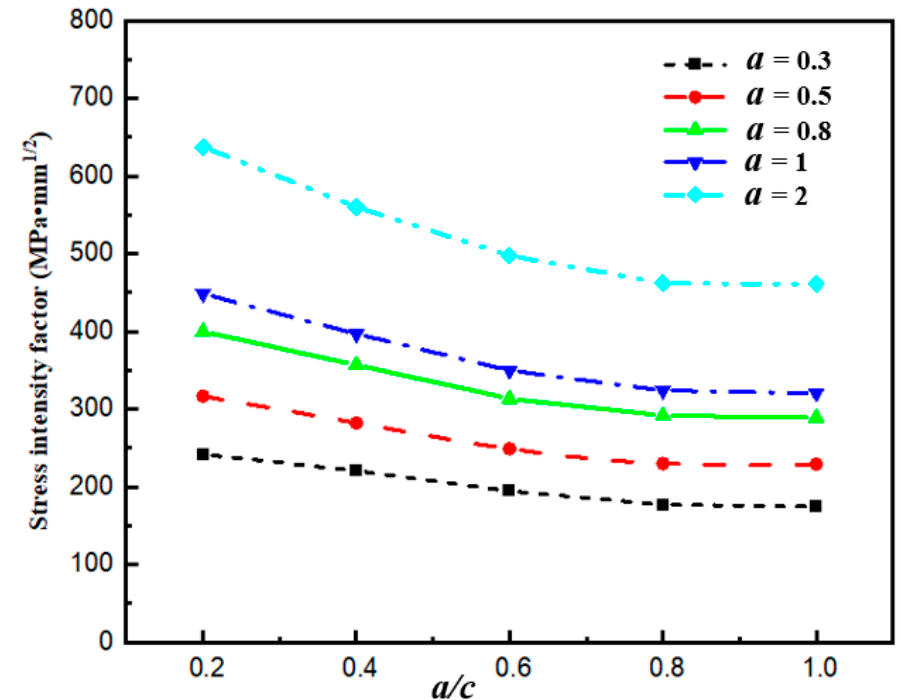
Figure 7. The maximum value of different cracks, K Ⅰ .